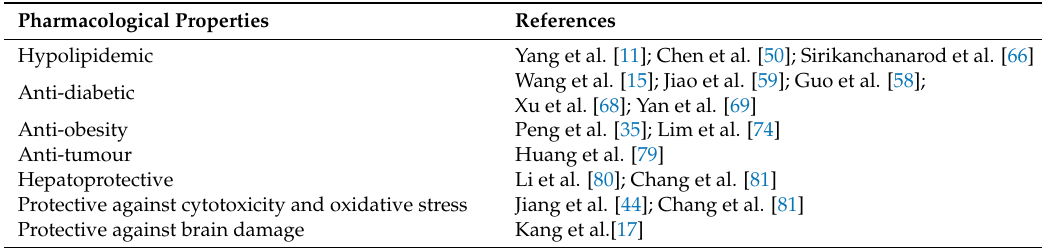
Table 1. An overview of animal studies investigating the pharmacological properties of mulberry fruits. Pharmacological